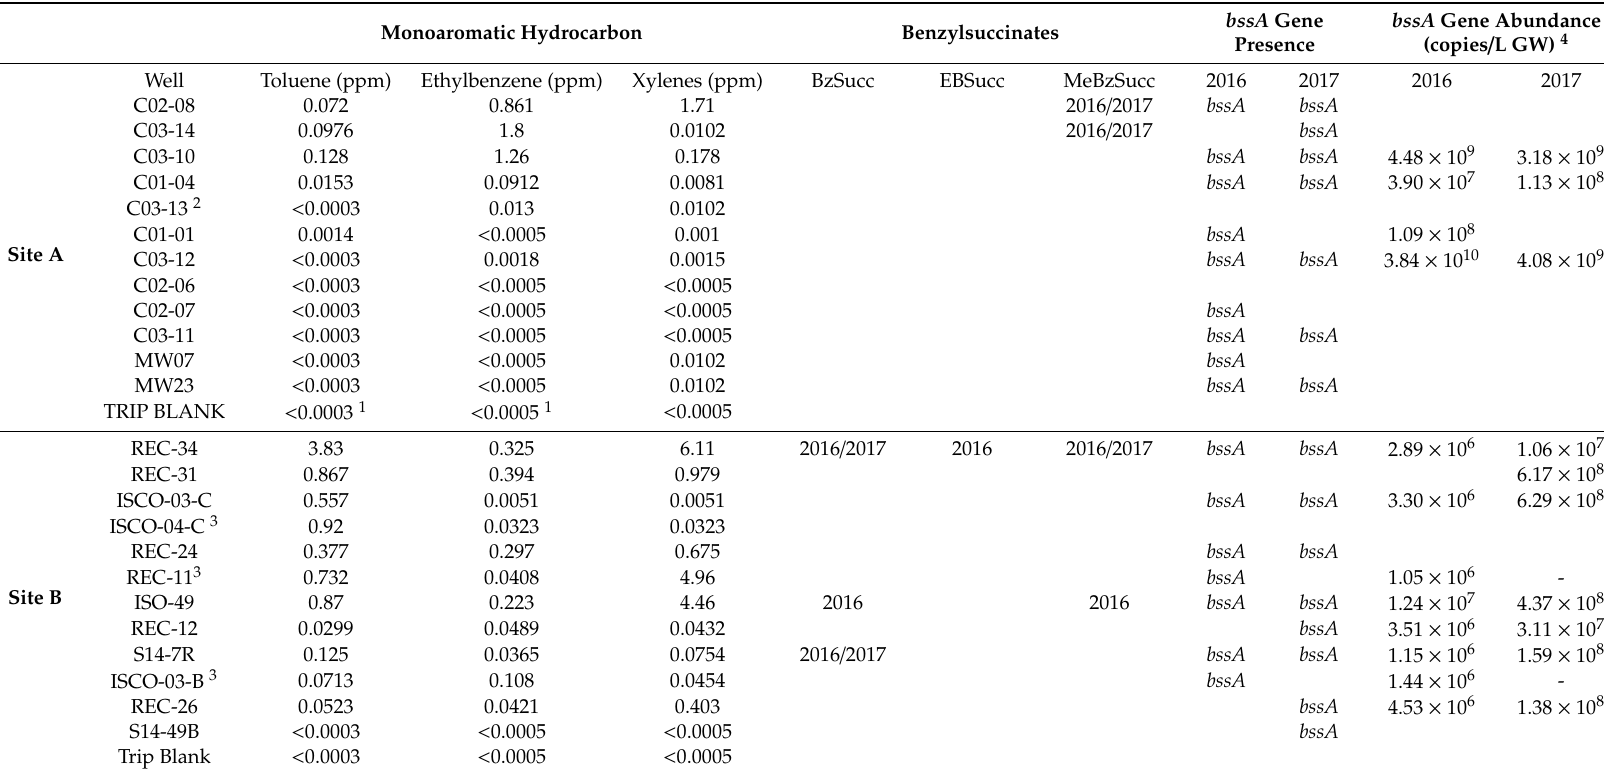
Table 3. Detection of TEX-derived fumarate addition metabolites and bssA genes (qualitatively and quantitatively determined) in Site A and B groundwater wells sampled in 2016 and 2017. “2016” or “2017” indicates that the metabolite was detected in that year, while “ bssA ” denotes gene detection. A blank space denotes absence of metabolite or